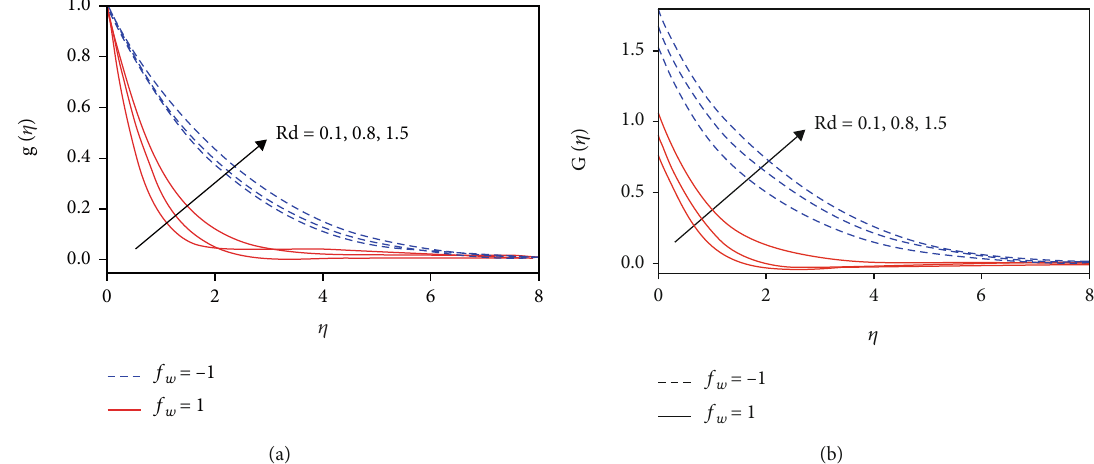
= 0 : 1, M = 1, K = 100, Q = 0 : 2, Ec = 0 : 6, and Pr = 2 1 p